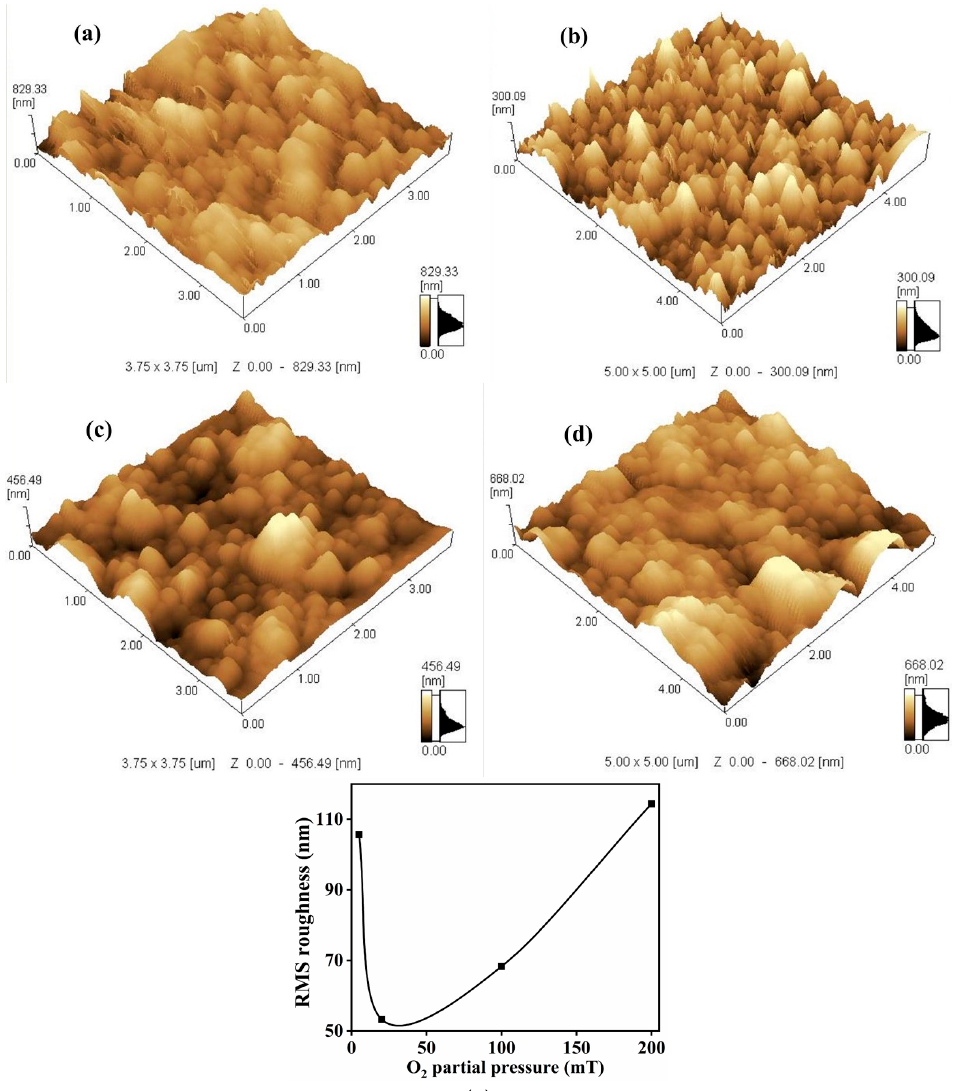
Figure 11. Three dimensional ‐ AFM images of Bi 2 O 3 :Ho 3+ (1 mol.%) film deposited in O 2 partial pressures for 15 min at ( a ) 5 mT, ( b ) 20 mT, ( c ) 100 mT and ( d ) 200 mT. ( e ) RMS roughness values of Bi 2 O 3 :Ho 3+ (1 mol.%) thin films deposited at different O 2 partial pressures.